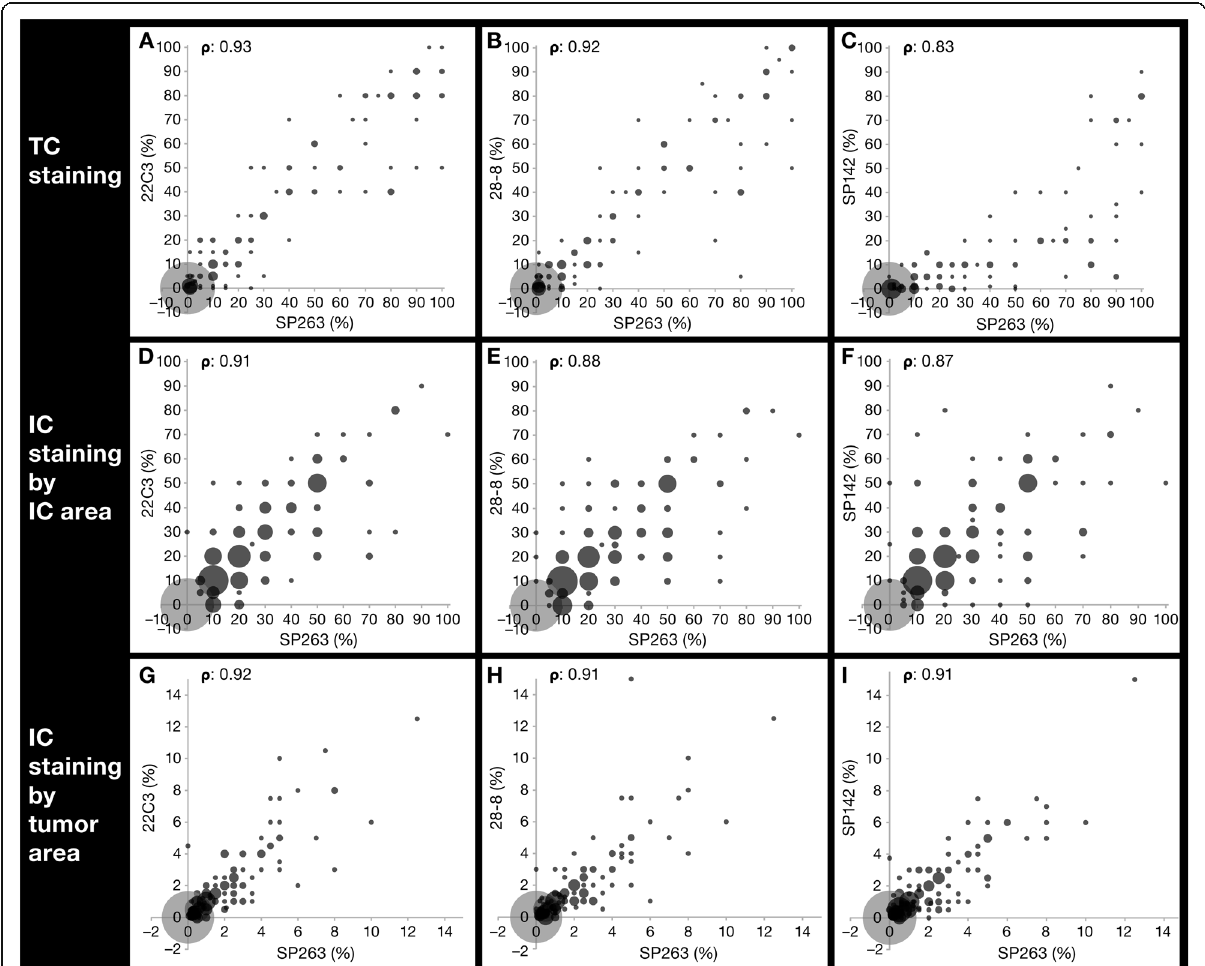
Fig. 2 Comparison between PD-L1 IHC 22C3 pharmDx, PD-L1 IHC 28 – 8 pharmDx and VENTANA SP142 versus VENTANA SP263. Pairwise comparison between PD-L1 IHC 22C3 pharmDx ( a , d , g ), PD-L1 IHC 28 – 8 pharmDx ( b , e , h ) and VENTANA SP142 ( c , f , i ) assays versus VENTANA SP263 for TC and IC PD-L1 staining and their corresponding pairwise Spearman rank correlation coefficients ( ρ ). Pairwise Spearman rank correlation coefficients without zeros were 0.90, 0.89, and 0.82 for tumor cell (TC) staining; 0.77, 0.73, and 0.65 for immune cell (IC) staining by IC area; and 0.85, 0.83, and 0.80 for IC staining by tumor area for PD-L1 IHC 22C3 pharmDx, PD-L1 IHC 28 – 8 pharmDx, and VENTANA SP142 versus VENTANA SP263, respectively. IC immune cell, IHC immunohistochemistry, PD-L1 programmed cell death ligand-1, TC tumor